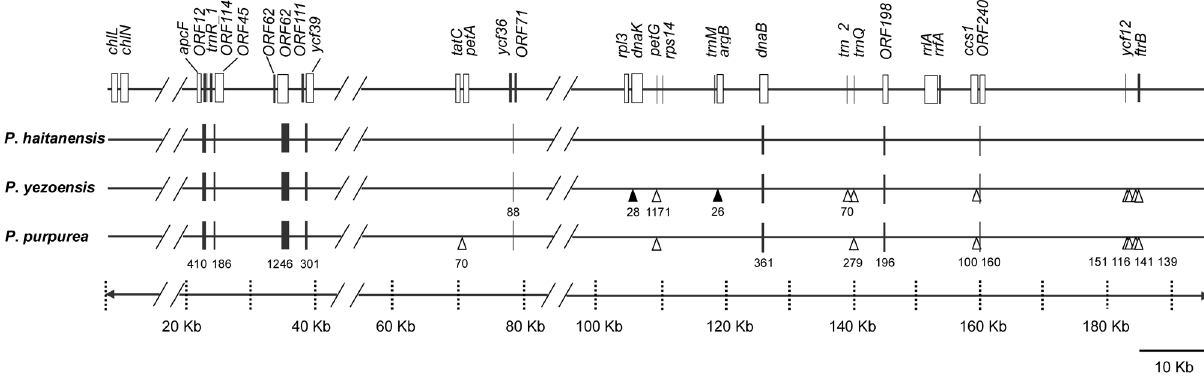
Figure 2. Comparison of plastid genomes of P . haitanensis , P . yezoensis , and P . purpurea . Insertions longer than 25 bp or deletions longer than 70 bp in P . yezoensis and P . purpurea in comparison with P. haitanensis are labeled as black triangles or white triangles individually. Highly diverse sequence regions larger than 80 bp are labeled with black blocks. Numbers indicate the longest length of comparative deletions, insertions, or diverse sequence regions of three Bangiales species.